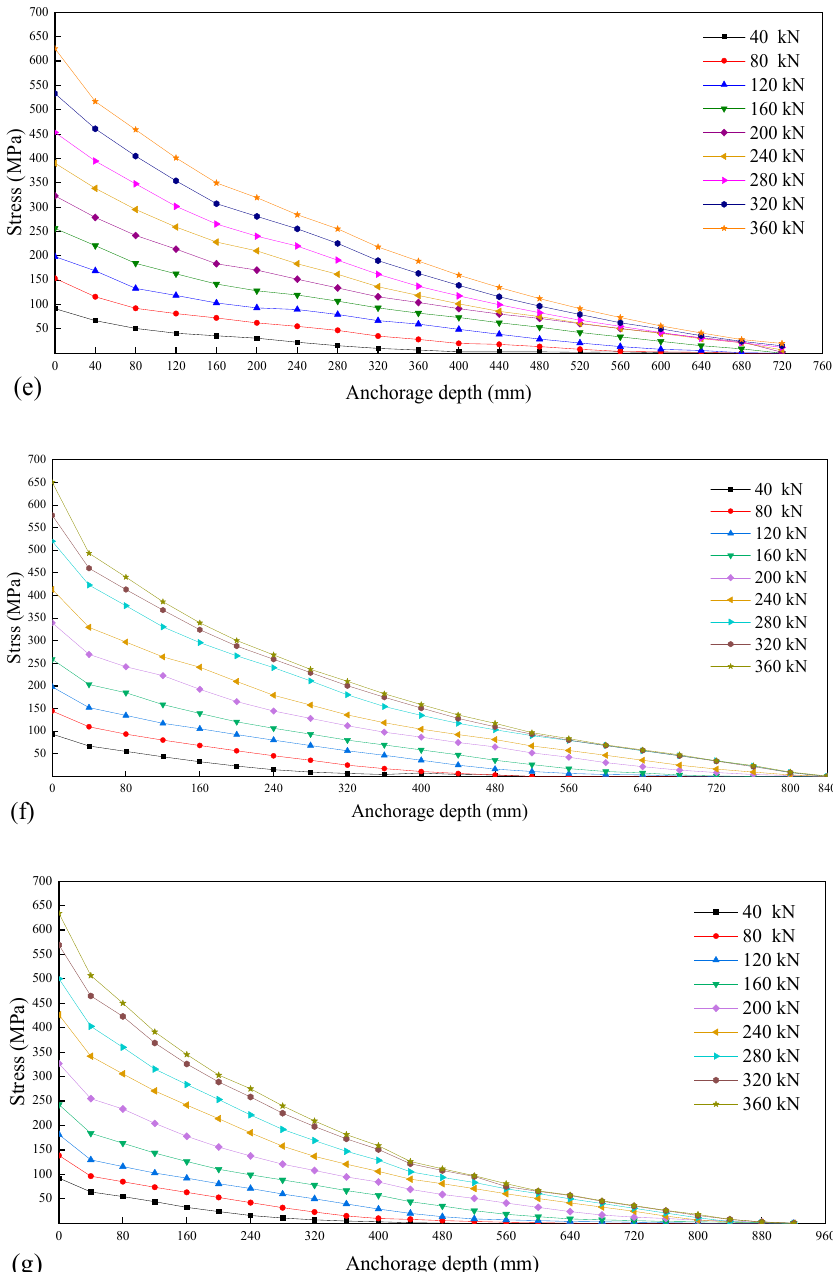
Figure 14. Variation law of bolt axial stress with anchoring depth: ( a ) 15 D /420 mm, ( b ) 18 D /504 mm, ( c ) 21 D /588 mm, ( d ) 24 D /672 mm, ( e ) 27 D /756 mm, ( f ) 30 D /840 mm, ( g ) 33 D /924 mm.